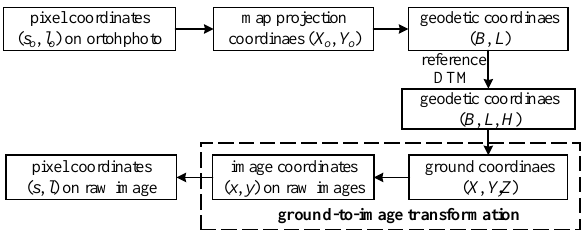
Figure 2. The coordinate transformation procedures in the orthorectification of pushbroom planetary images.